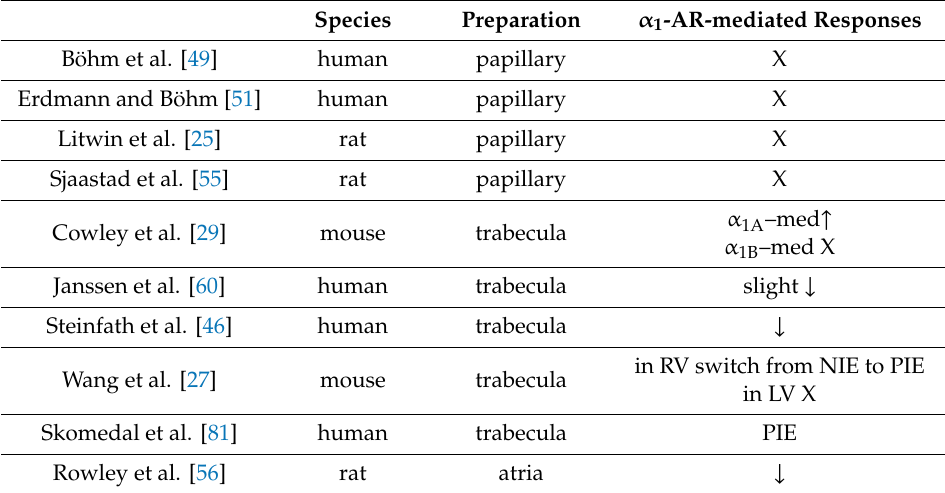
Table 3. Summary of changes in cardiac α 1 -adrenoceptor (AR)-mediated responses in chronic heart failure. Species Preparation α 1 -AR-mediated Responses Böhm et al. [49] human